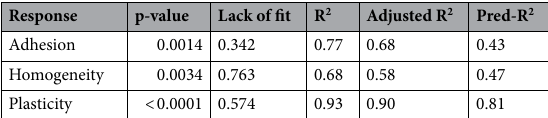
Table 6. ANOVA results.